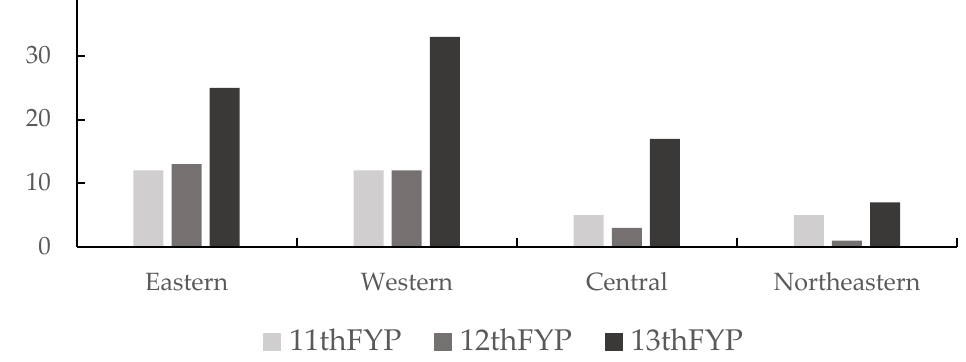
Figure 9. Spatial differences of the number of provinces in category SD during the study period.